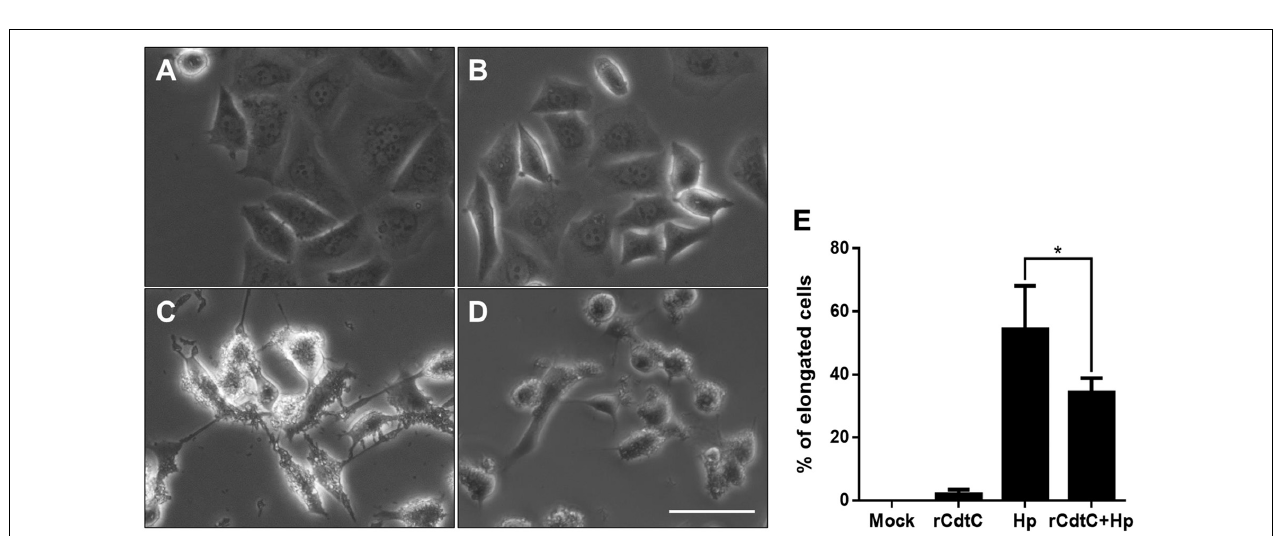
FIGURE 3 | rCdtC attenuates Helicobacter pylori -induced cell scattering. AGS cells were (A) untreated with rCdtC, (B) treated with 200 nM rCdtC alone, (C) infected with H. pylori for 6 h, and (D) pretreated with rCdtC then infected with H. pylori for 6 h. Scale bar, 100 µ m. (E) The elongated cells were counted and expressed as percentage compared to the untreated cells. The results were performed in three independent experiments and represented as mean ± SD (* P <